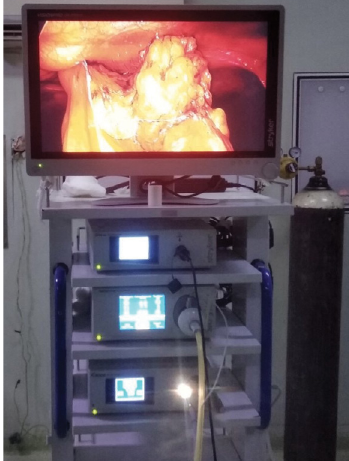
Figure 1: HME filter was connected to a gas